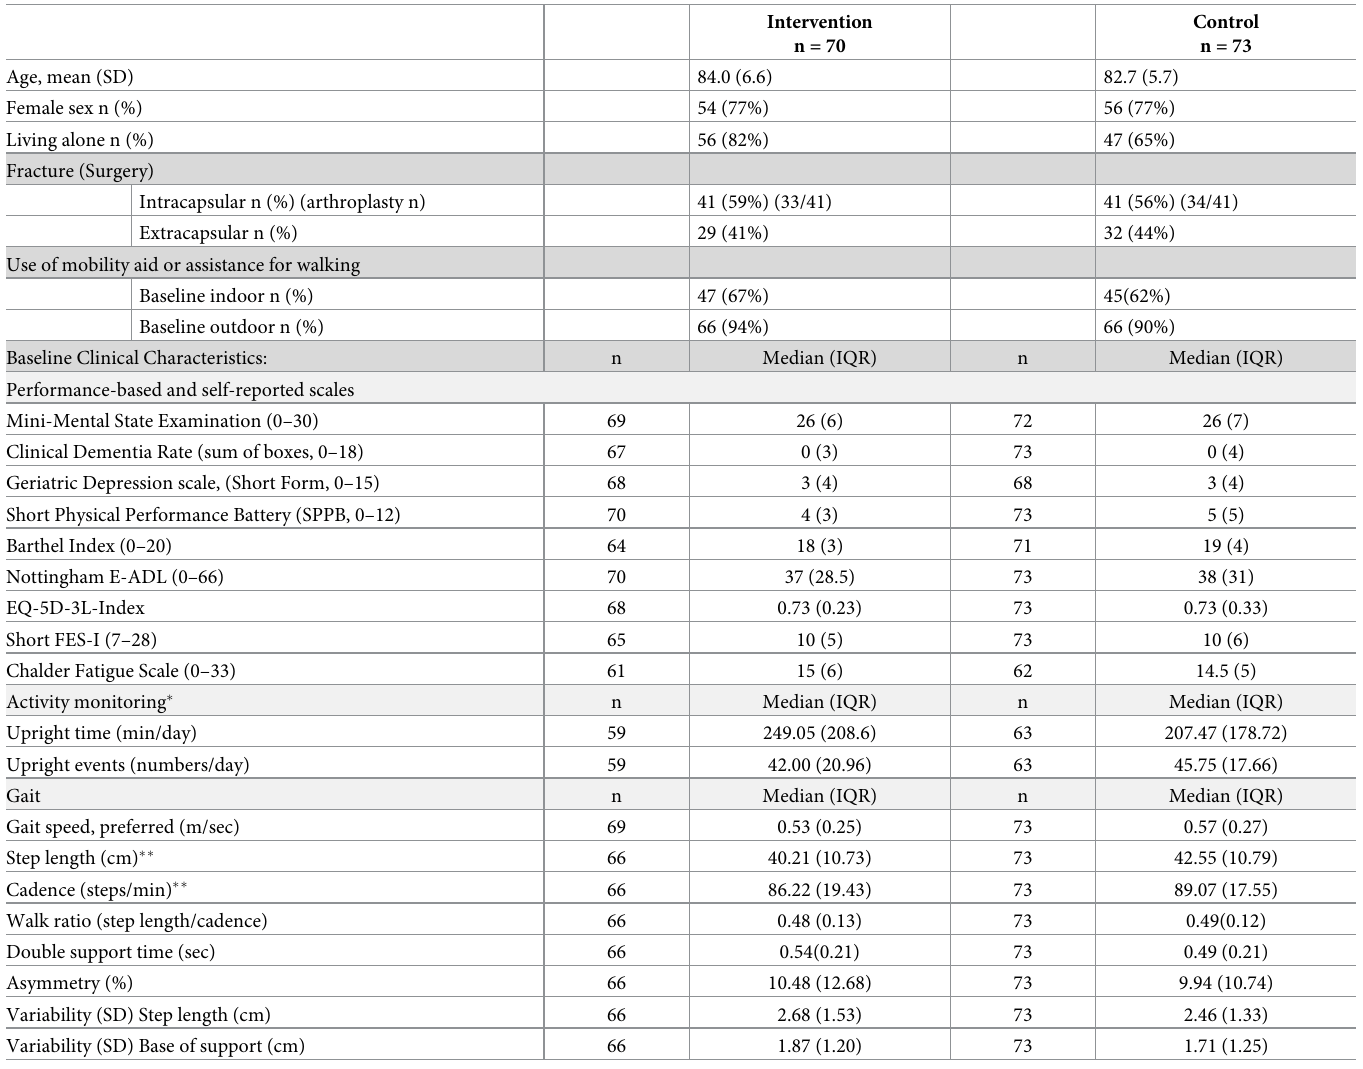
Table 1. Demographics and baseline clinical characteristics (n =